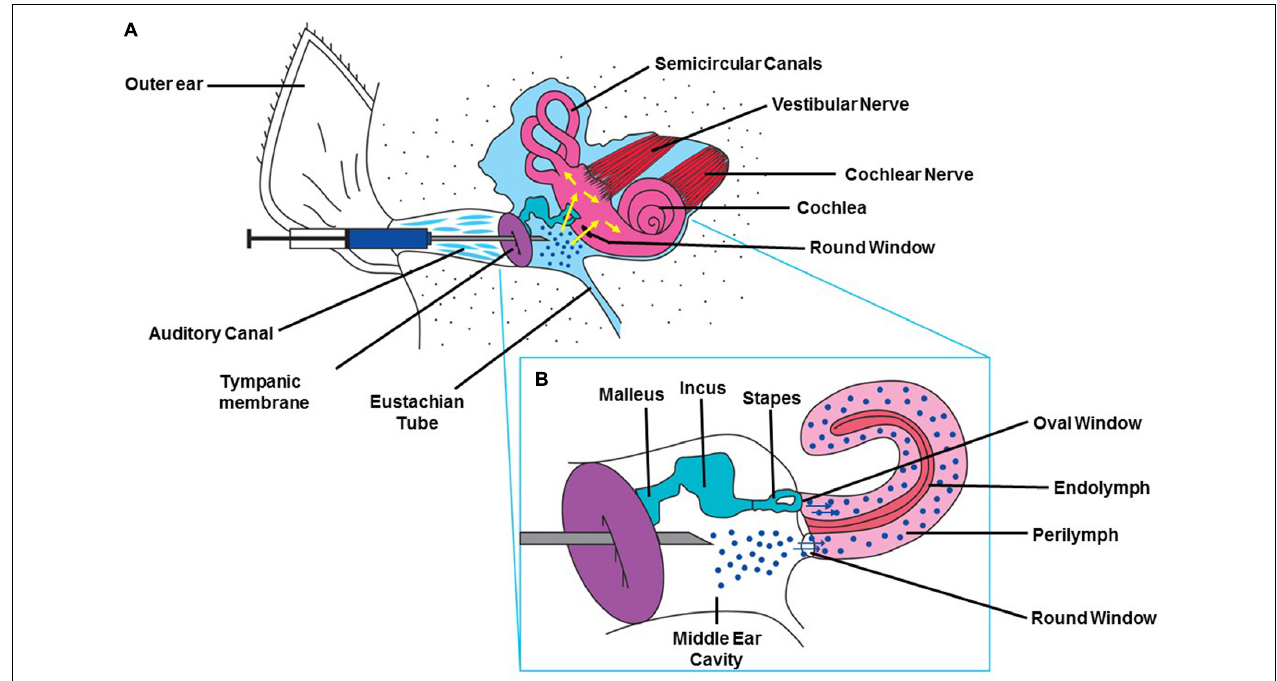
FIGURE 3 | Method for intra-tympanic injection. (A) A syringe with an attached 30 gage needle 1 / 2 to 5/8th of an inch in length is directed through the external ear canal to the tympanic membrane of anesthetized animal with an operating microscope. A single puncture is made in the anterior inferior region. The desired solution is slowly injected into the middle ear and the rat is left undisturbed for 15 min with injected ear facing upward (Sheehan et al., 2018). (B) Drawing depicting the injected drug traversing the RWM and entering the cochlea. This figure was modified with permission from the image screenshot at 1:59 of the article